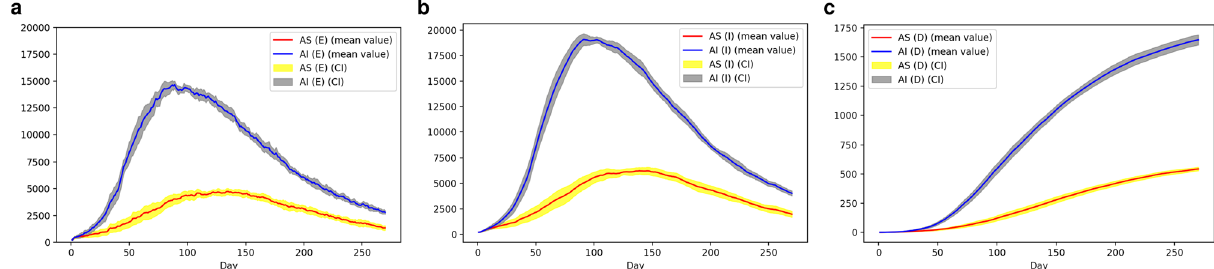
Figure 6. Stochasticity of PanCitySim Mean and 95% confidence intervals of predictions for Exposed cases ( E ), Infectious cases ( I a + I s ), and Deaths ( D ) respectively, based on 10 runs of PanCitySim for the full population for each prototype city: Auto Sprawl (AS) and Auto Innovative (AI).